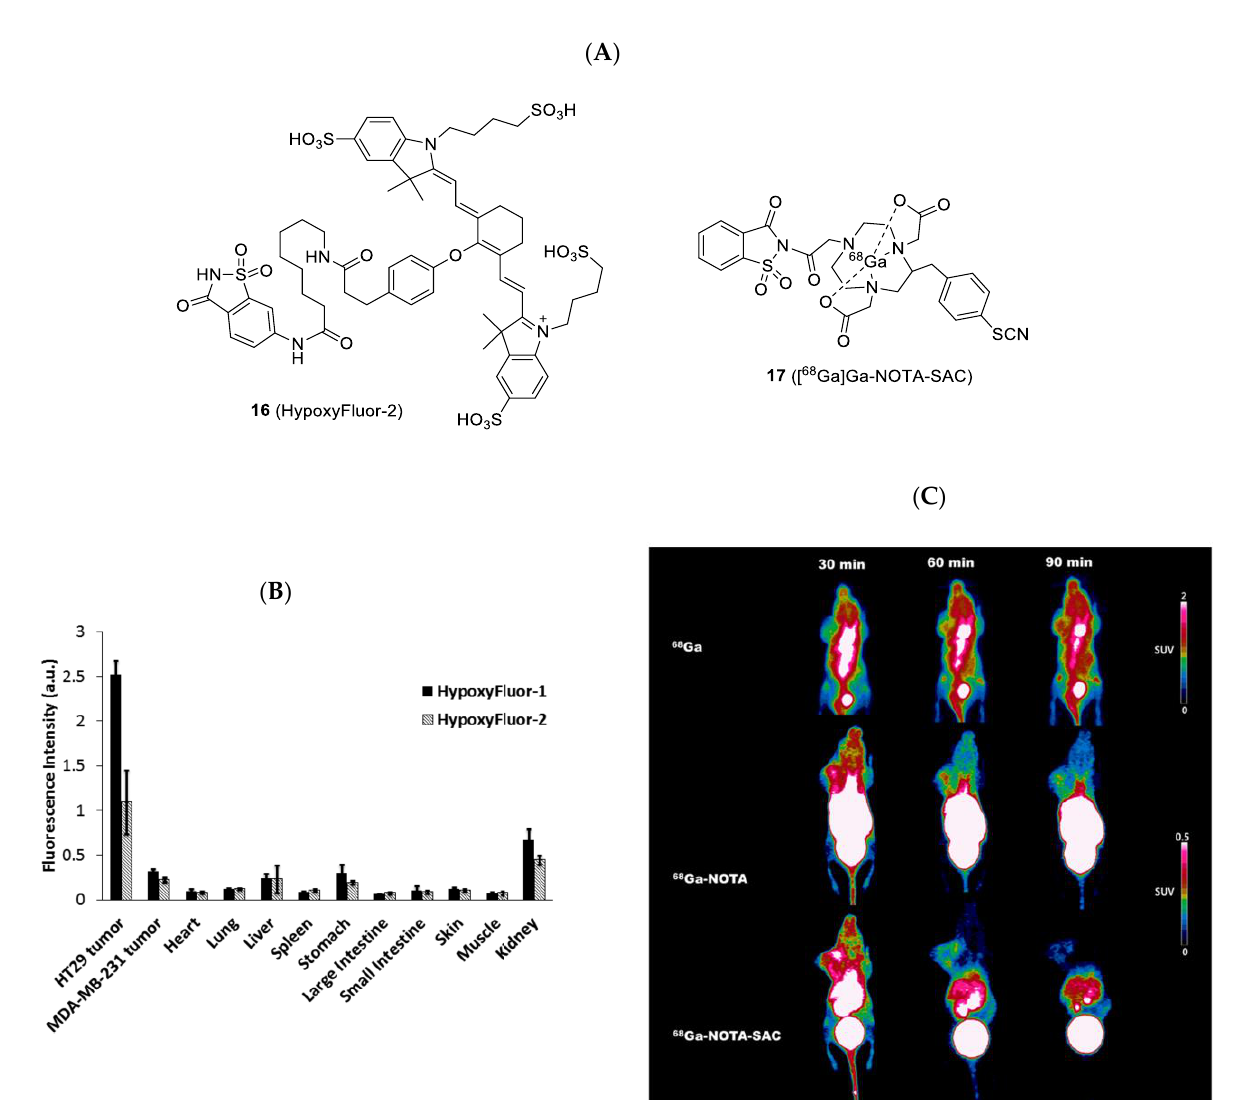
Figure 7. ( A ) Chemical structure of 16 and 17 . ( B ) Comparison of the fluorescence intensity of HypoxyFluor-1 ( 12 ) and HypoxyFluor-2 ( 16 ) in HT-29 tumor-bearing mice. ( C ) PET image analysis of free 68 Ga, [ 68 Ga]Ga-NOTA, and [ 68 Ga]Ga-NOTA-SAC 17 at 30, 60, 90, min PI, respectively.